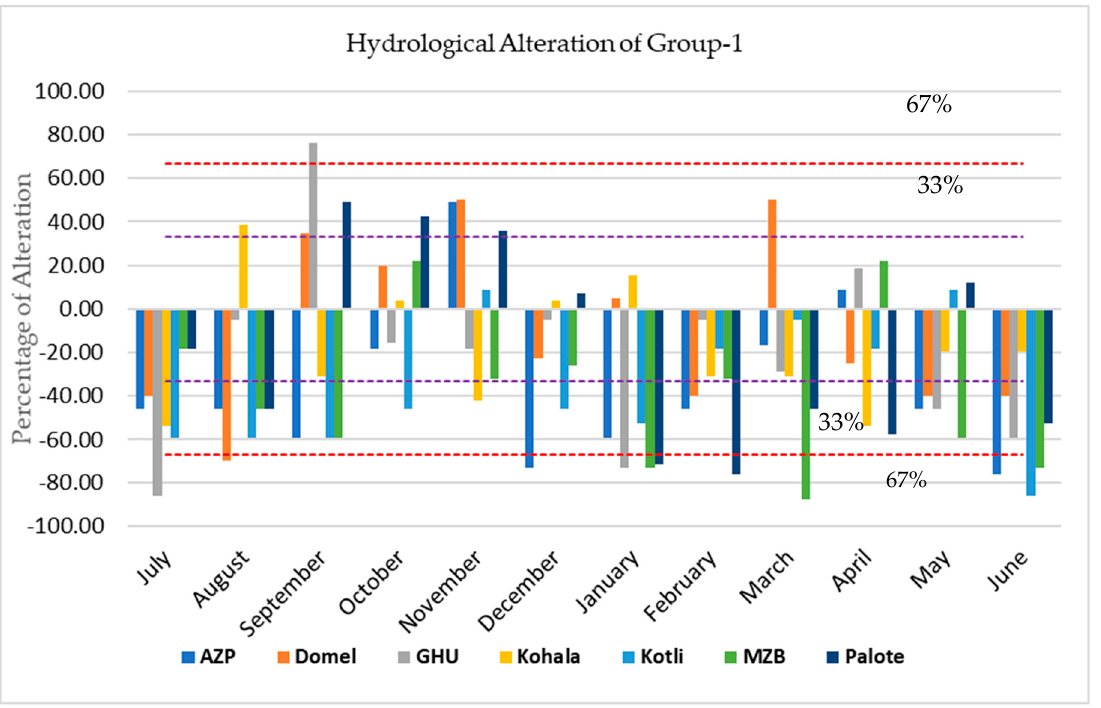
Figure 3. Hydrological Alteration of Group − 1 indicators.